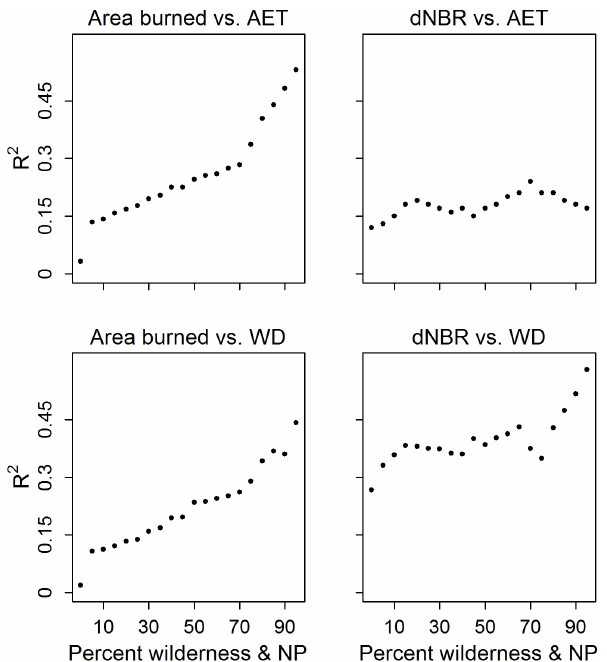
Figure 4. Strength of the relationship (R 2 for all models except the dNBR vs. AET model, which is evaluated with the r 2 ; see Methods) for all models as a function of increasing percentage of wilderness and national park in each